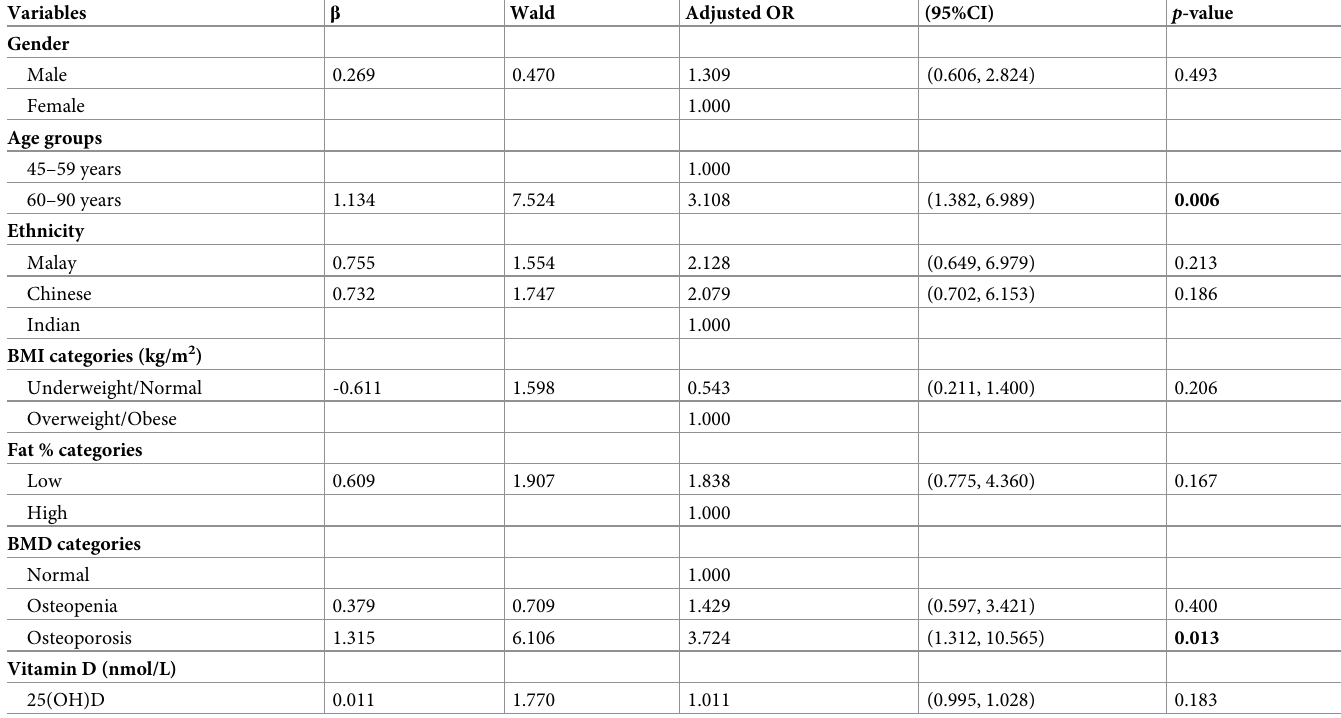
Table 3. Factors associated with vertebral